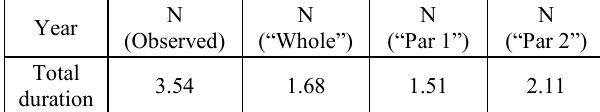
Table 3. Total Nitrogen results from model simulation, considering only punctual pressures (total simulation duration average).